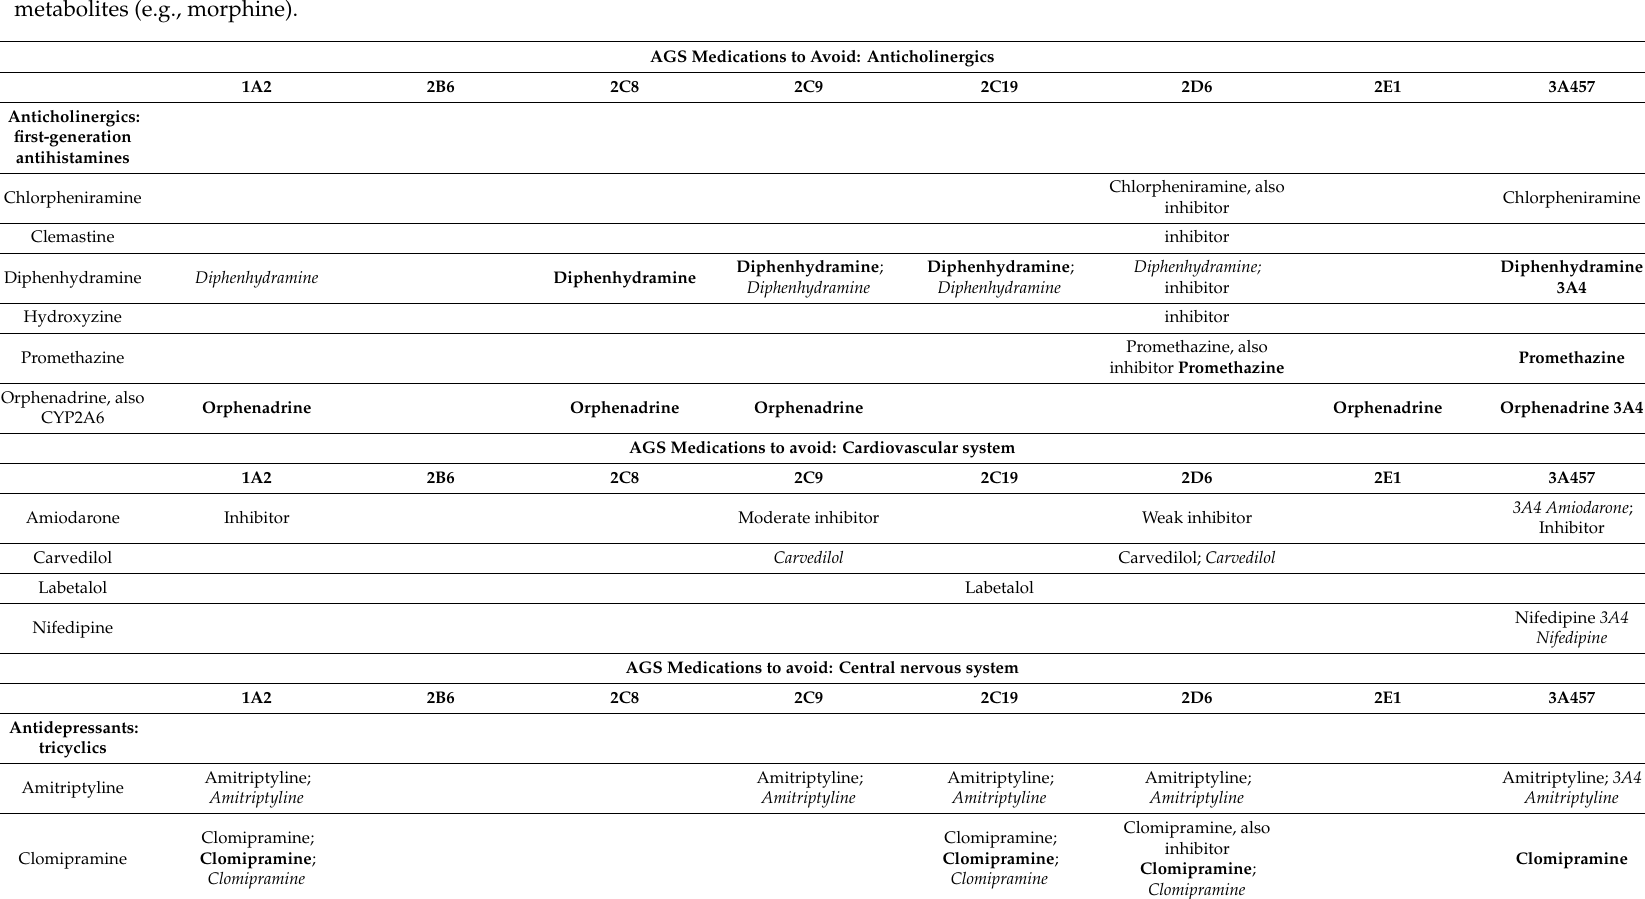
Table 5. American Geriatric Society 2019 criteria for Potentially Inappropriate Medication Use in older adults for which the P450 cytochrome isoform is known. Sources: Bold print = DrugBank [25]; Regular print = Flockhart Table [26]; Italic Print = Rx Files. 12th ed. [27]. If a medication name is given it indicates it is a substrate metabolized by the P450 cytochromes in the columns listed. If a medication is also an inducer of individual P450 cytochromes the word inducer is used. If a medication is an inhibitor of individual P450 cytochromes the word inhibitor is used. (Inhibitors increase levels of medications metabolized by the same isoform. Inducers decrease levels of medications metabolized by the same isoform). However, if they metabolize a prodrug (e.g., codeine) the result is higher levels of its metabolites (e.g.,